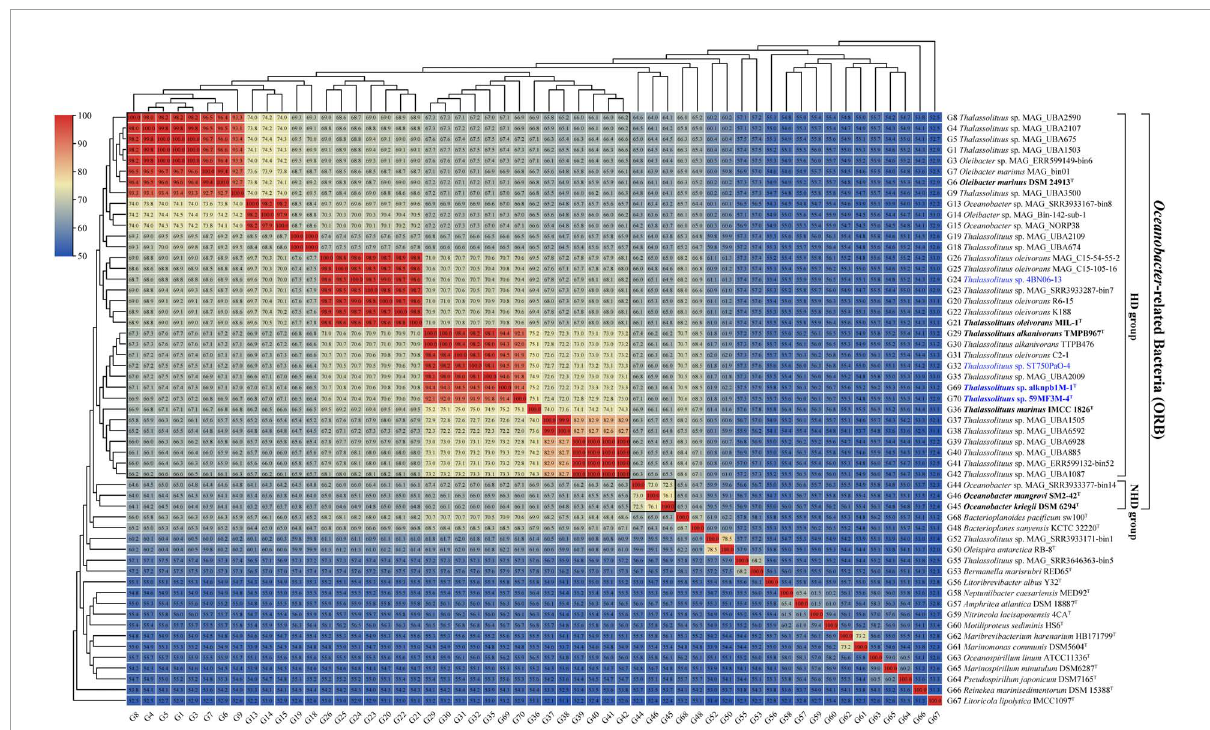
FIGURE3 Amino acid identity (AAI) value matrices from pairwise genome comparisons. The heatmap shows AAI values (in each color block) between genomes, along with the phylogenomics tree ( Figure 2A ) cladogram to show relationships. The boxed regions indicate inferred genera within the Oceanobacter -related bacteria (ORB) based on AAI comparisons, as well as monophyly in the genome-based phylogenetic tree ( Figure 2A ). Similarly, inferred genera were also observed from the percentage of conserved proteins (POCP) value matrices ( Supplementary Figure 2 ). Genomes retrieved from the strains isolated in this study and the type strains of ORB are highlighted in blue and black bold, respectively. Genomes retrieved from the metagenome-assembled genomes are marked by "metagenome-assembled genomes (MAG)" in their